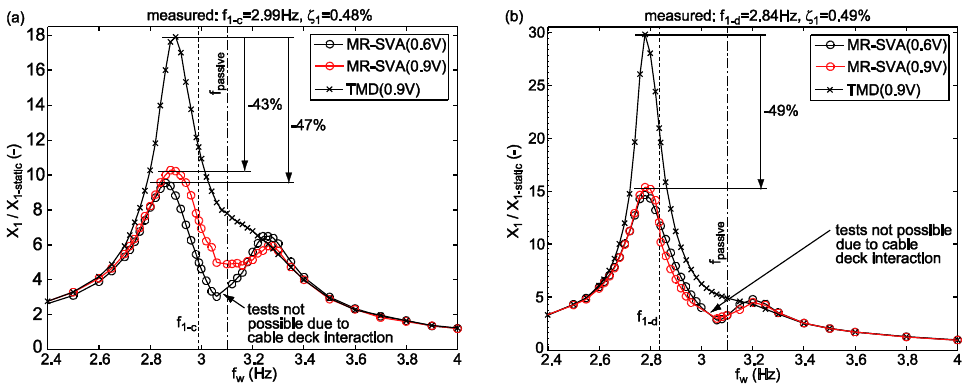
Figure 17. Measured vibration reductions of heavier bridges with ( a ) c1 f and ( b ) d1 f .